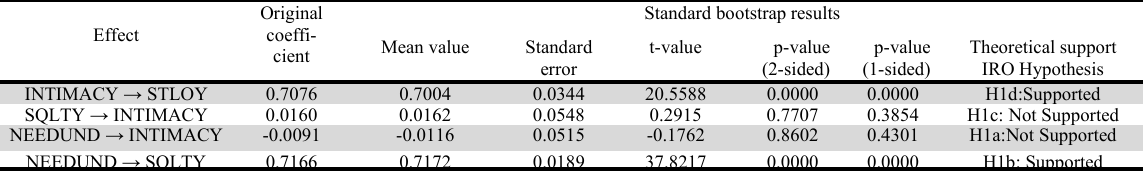
Direct effect inference